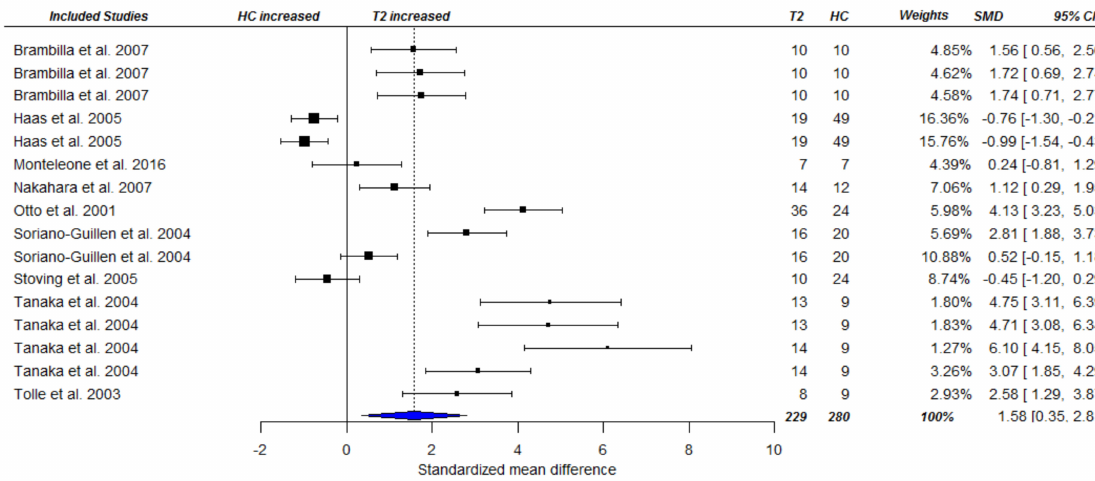
Figure 6. Forest plot of cross-sectional comparison between AN patients at follow-up (T2) and HCs on total ghrelin. Studies shown more than once had more than one follow-up occasion, or AN subtype.